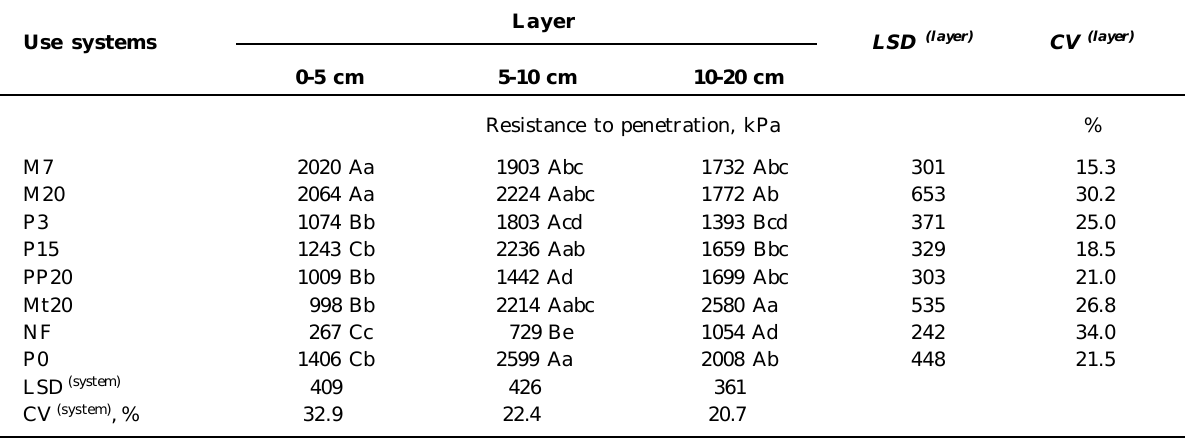
Table 8. Soil resistance to penetration at -6kPa matric potential of a Rhodic Kandiudox, in areas under different land use systems and application periods of pig and poultry organic fertilizers